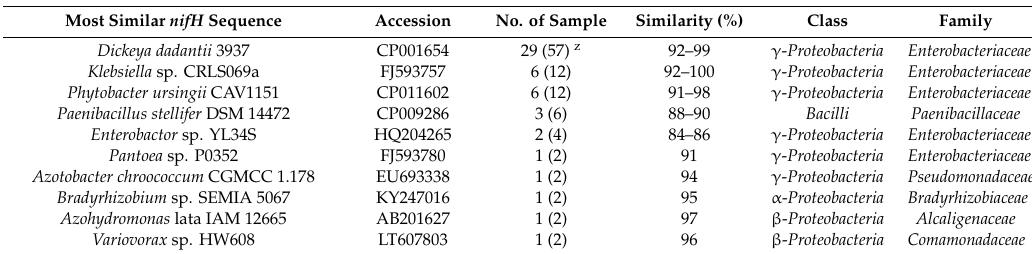
z Figures in parentheses indicate relative